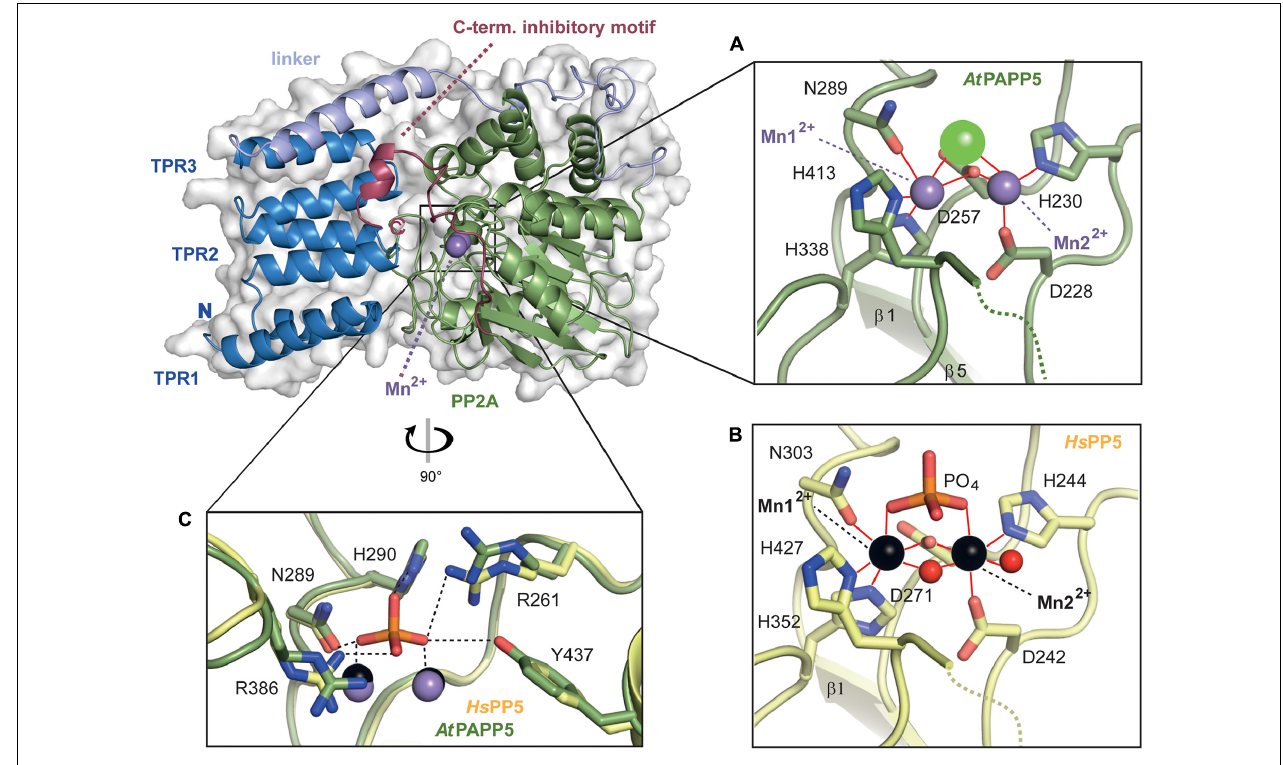
FIGURE 4 | Close-up view of the active site of At PAPP5. (A,B) Detailed presentation of the coordination spheres of the manganese ions in the phosphatase At PAPP5 and Hs PP5 (PDB Code: 1S95). Interactions of amino acids with the Mn 2 + ions ( At PAPP5: purple, Hs PP5: black) are shown in red. A green sphere represents a chloride ion and red spheres water molecules. (C) Superposition of the phosphate binding site of At PAPP5 and Hs PP5 (PDB code: 1S95). The interactions between the phosphate and the amino acids are shown as black dashed lines. The numbering of the amino acids refers to At